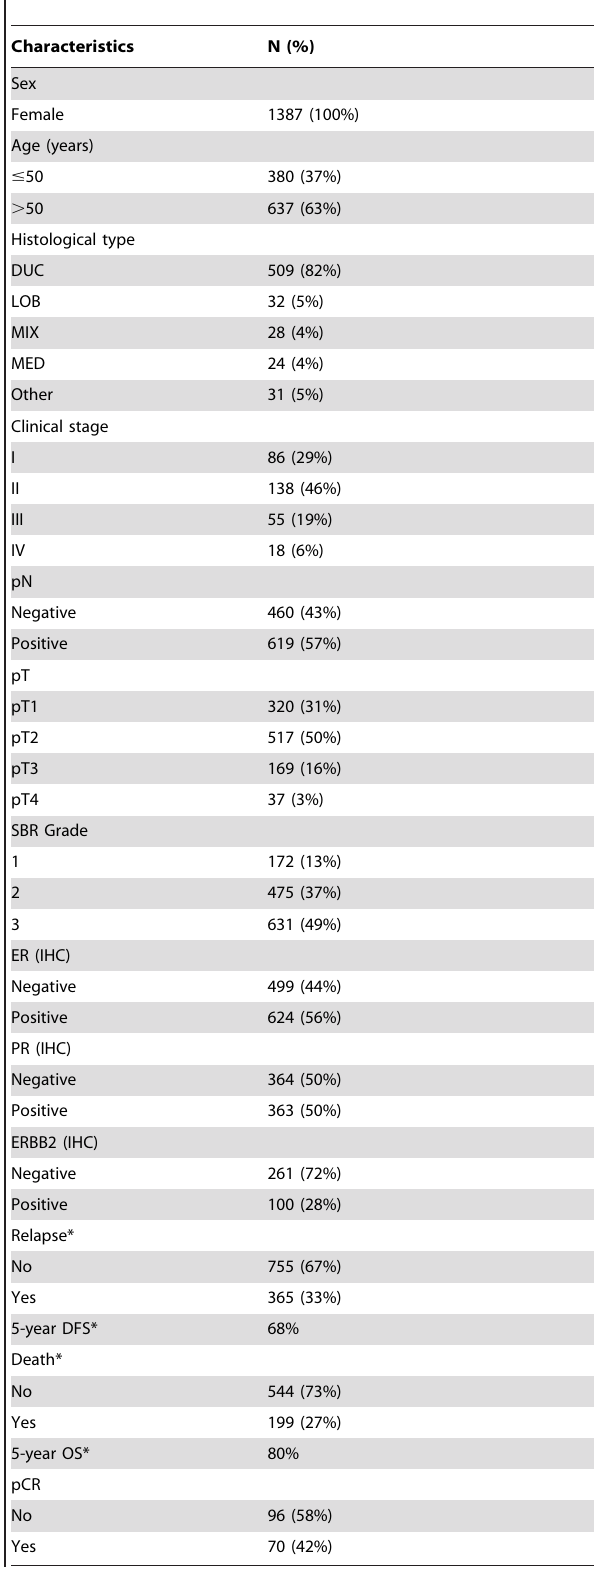
Table 1. Histo-clinical characteristics of the 1,387 breast cancer patients.